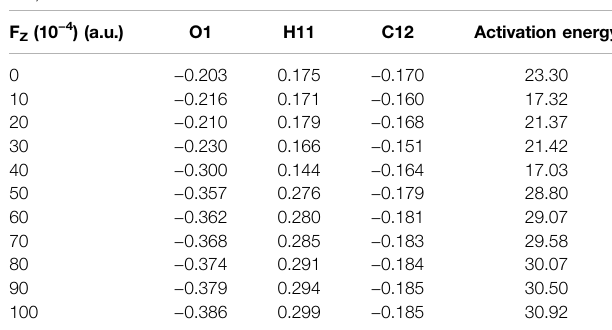
TABLE 3 | | Mulliken charges (|e|) of some atoms in the reactive centre of the transition state and activation energies Δ E 0 (electronic energies + ZPE: kcal/ mol) under an electric fi